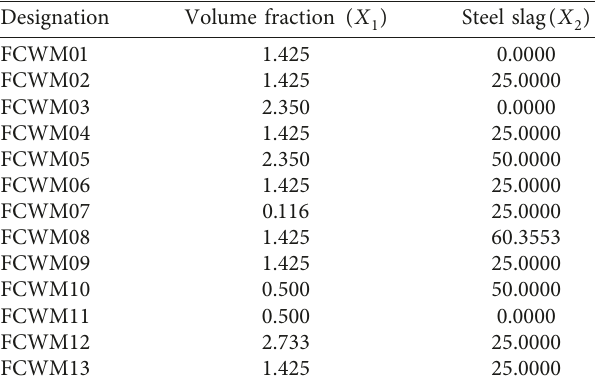
Table 2: Details of test specimen with galvanised square weld mesh for flexure